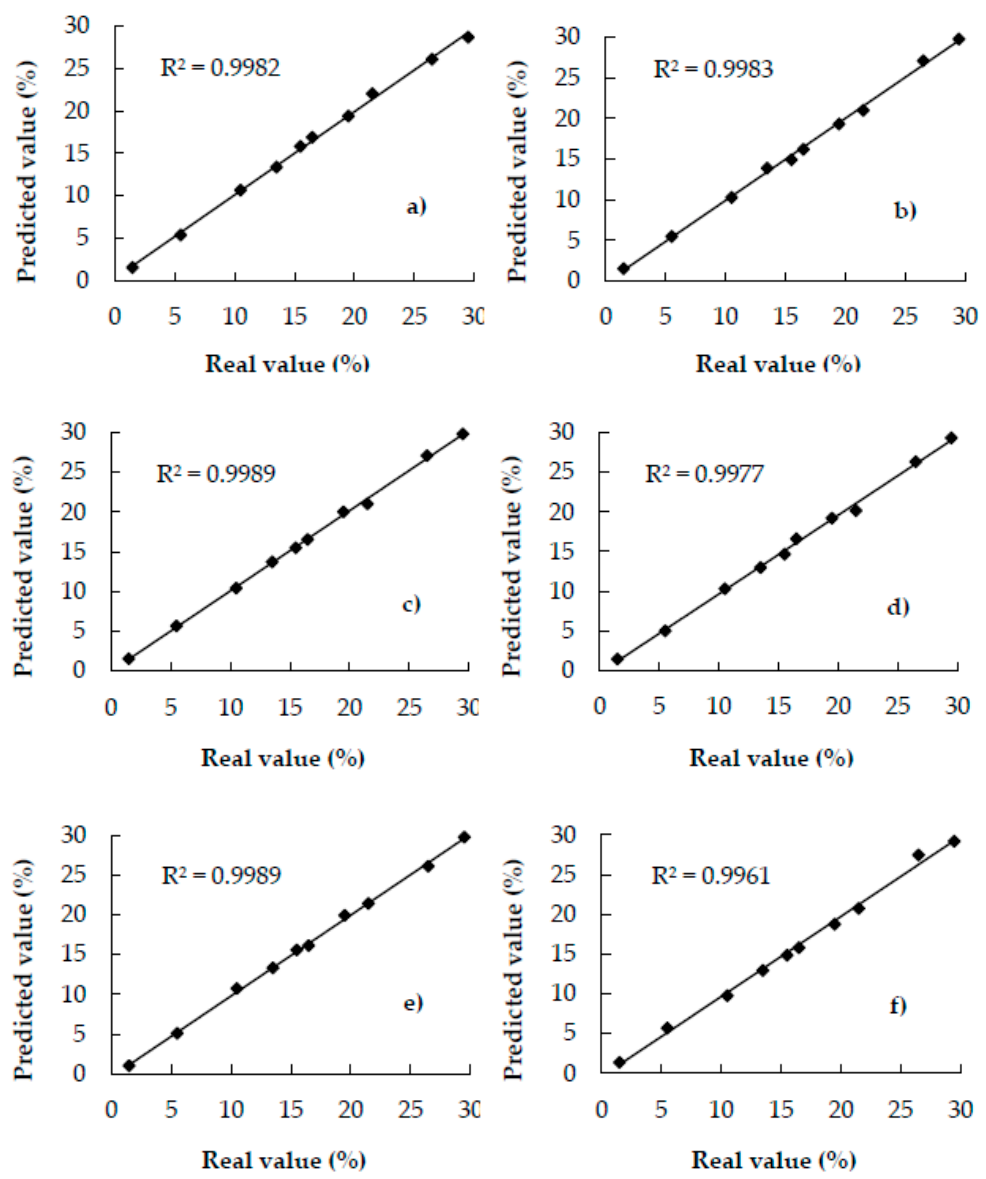
Figure 4. Scatter plots of actual and predicted values of coffee adulterated with—( a ) coffee husks, ( b ) corn, ( c ) barley, ( d ) soy, ( e ) oat, and, ( f ) rice of validation samples.